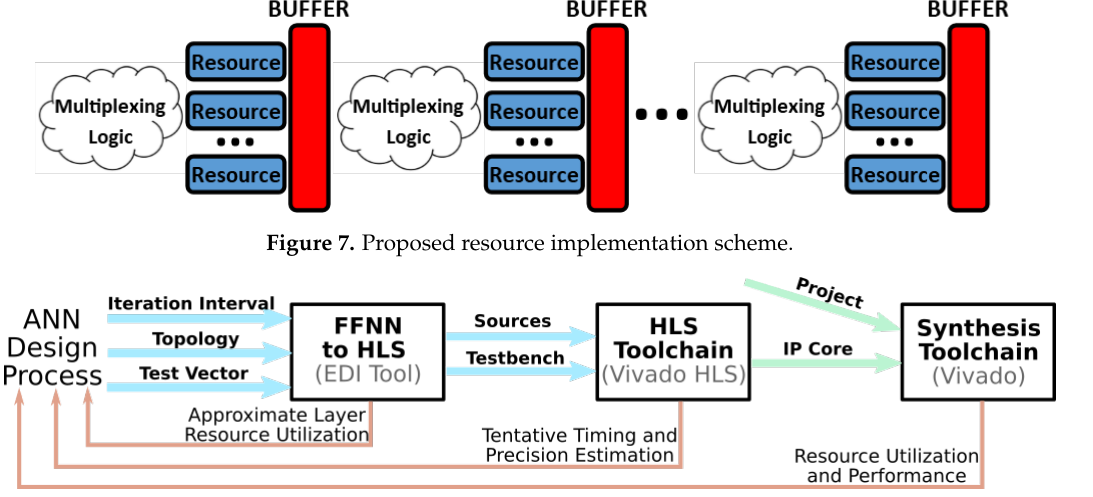
Figure 8. Tool flow of the proposed ANN development.